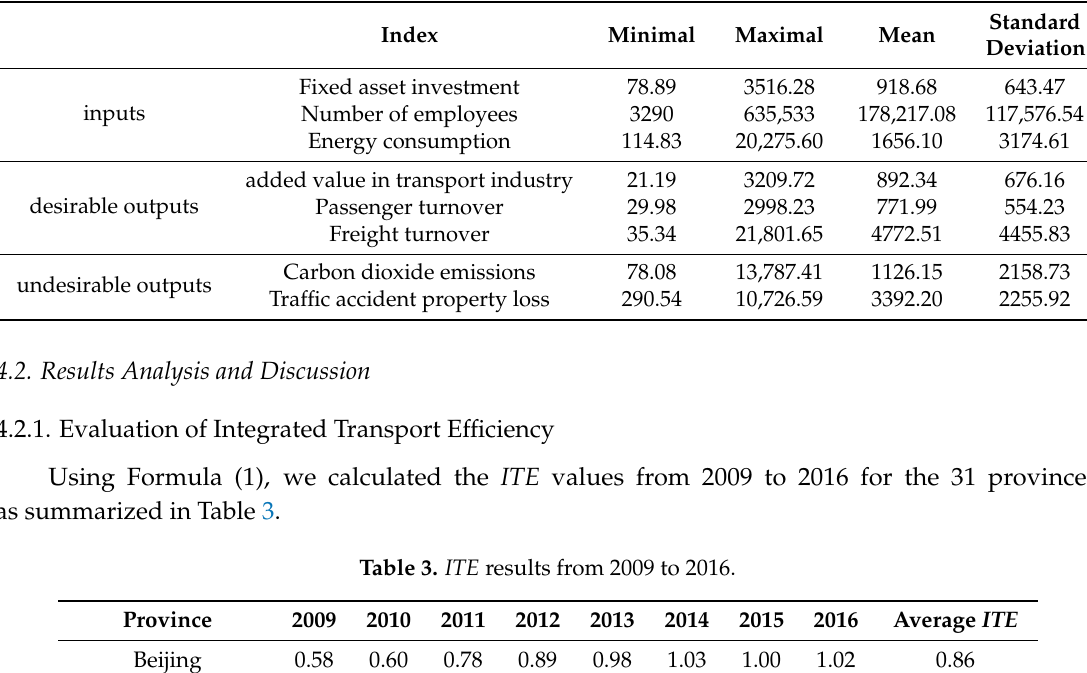
Table 3. ITE results from 2009 to 2016.